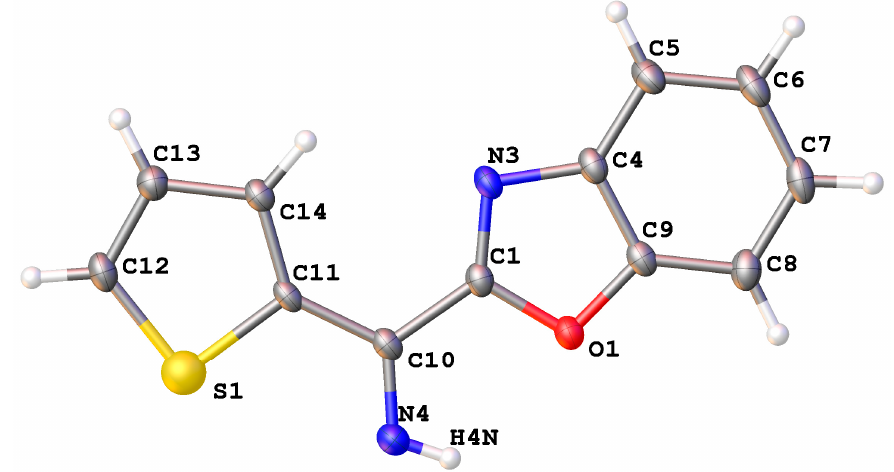
Figure 1. The general view of benzo[ d ]oxazol-2-yl(thien-2-yl)methanimine 9f in representation of = atoms by thermal ellipsoids ( p = 50%). atoms by thermal ellipsoids ( p